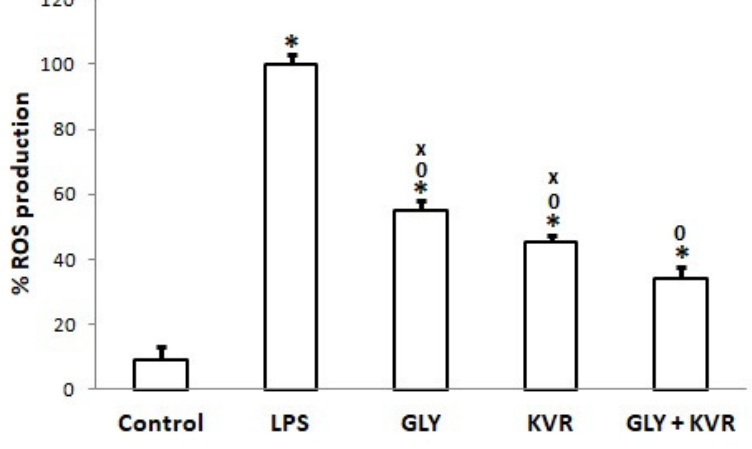
Figure 2. Effect of glycine and kolaviron on lipopolysacharide (LPS) -induced production of ROS in U937 cells LPS, cells treated with 1 µg/ml Lipopolysaccaride only; GLY, cells supplemented with Glycine (300 µM) before exposure to Lipopolysaccharide (1 µg/ml); KVR, cells supplemented with Kolaviron (25 µg/ml before exposure to Lipopolysaccharide (1 µg/ml); GLY + KVR, Cells supplemented with both Glycine and Kolaviron (300 µM GLY + 25 µg/ml KVR) before exposure to Lipopolysaccharide. Each bar represents mean ± S.E.M of six replicates expressed as % production in comparison to LPS. *Significantly different from control; o Significantly different from LPS and x Significantly different from GLY + KVR. p < 0.05.